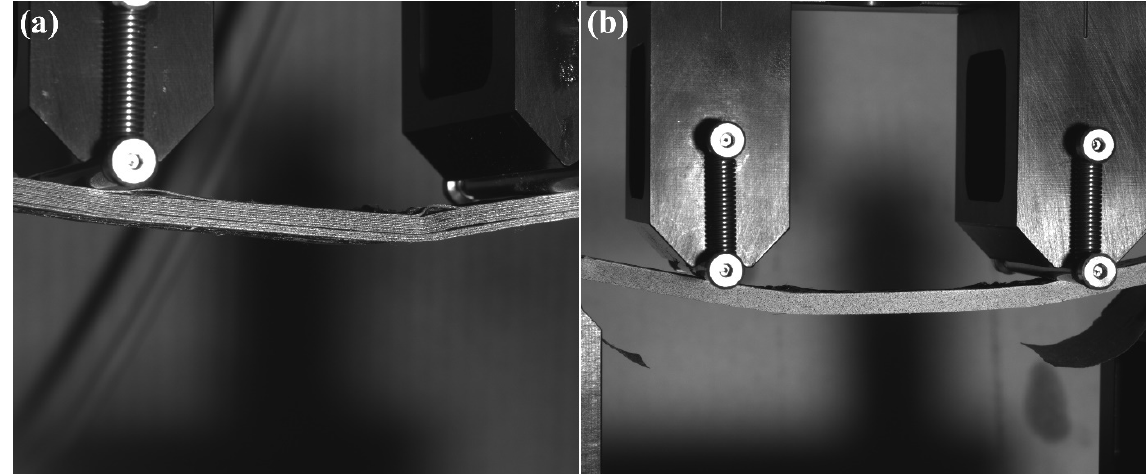
Figure 9 . Specimen Nr. 3 of N-PA6-CFC showing delamination ( a ) and specimen Nr. 2 of Figure 9. Specimen Nr. 3 of N-PA6-CFC showing delamination ( a ) and specimen Nr. 2 of N-PA6- N-PA6-CFC-PC showing buckling with little delamination at failure ( b ). CFC-PC showing buckling with little delamination at failure ( b